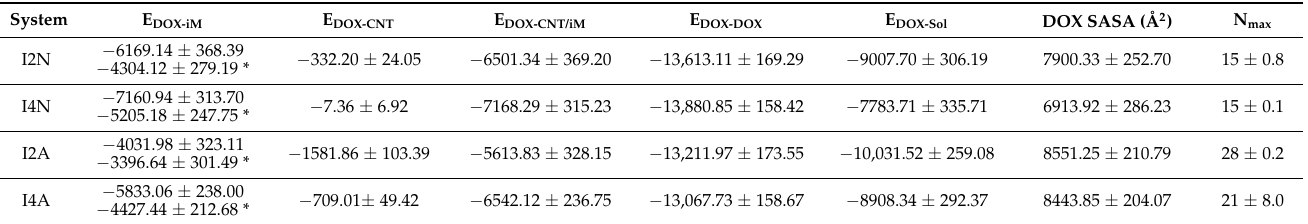
Table 2. Pair interaction energies (sum of Coulomb and Lennard-Jones contributions) of DOX with other components of the systems, solvent accessible surface area for DOX and number of DOX molecules in the biggest cluster. Energies are expressed in kJ mol − 1